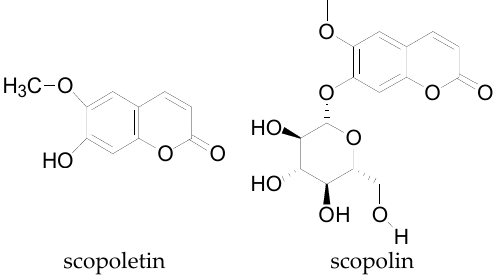
Figure 15. Chemical structures of scopoletin and its glycoside scopolin.